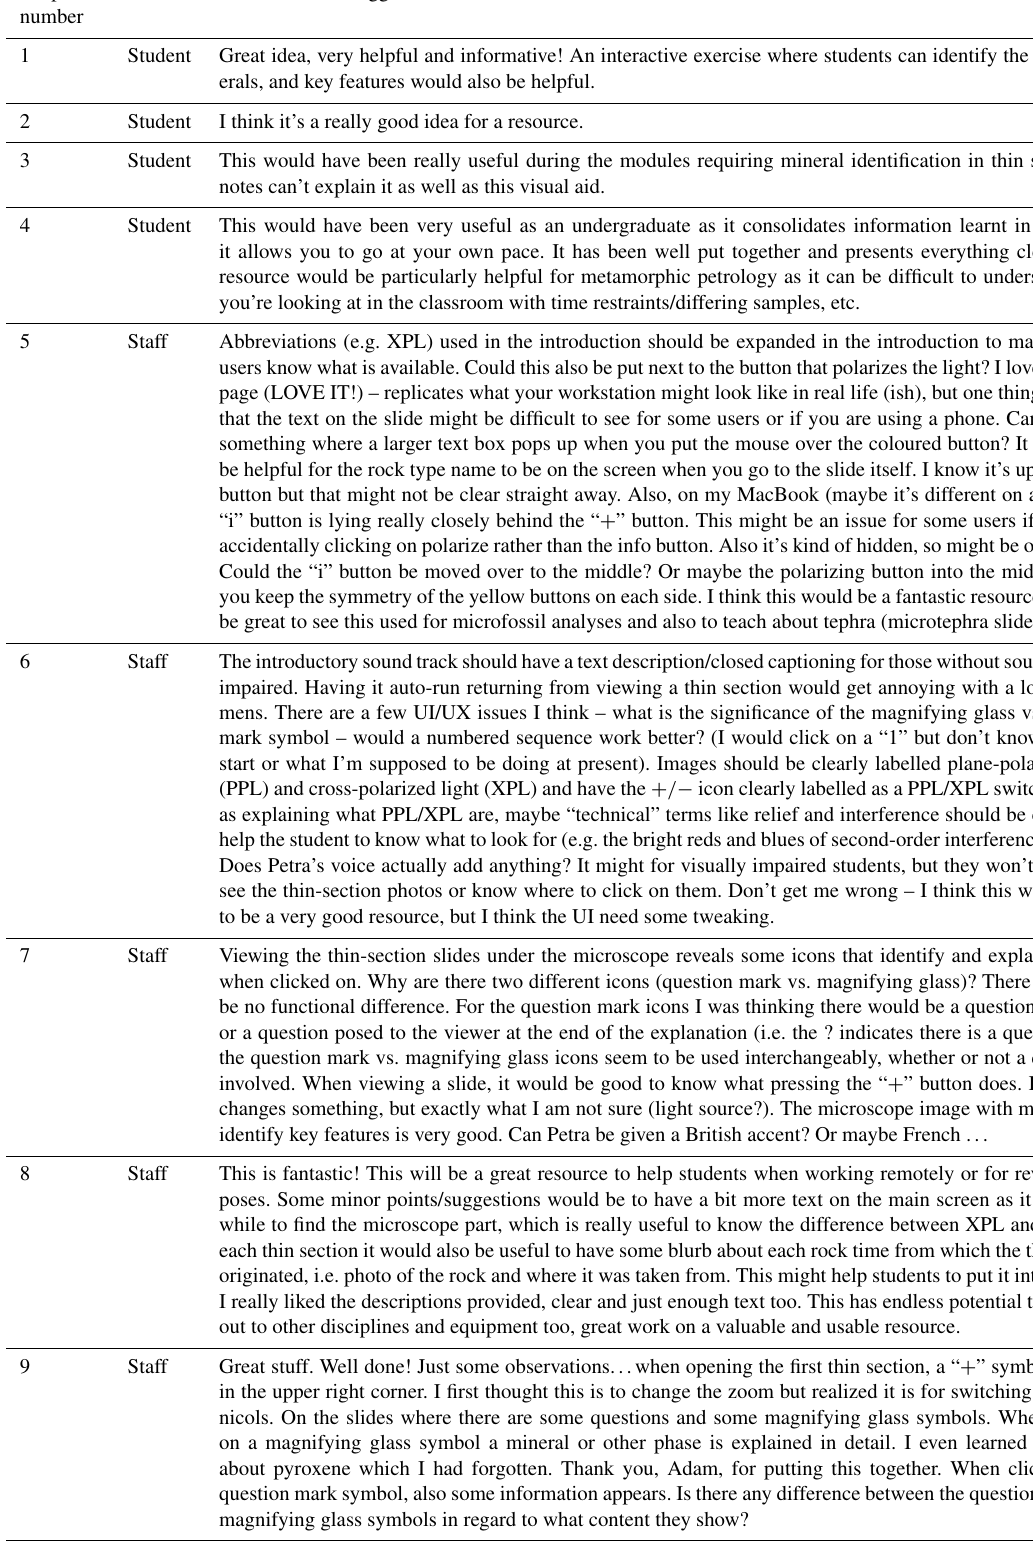
Table 1. Additional user comments and